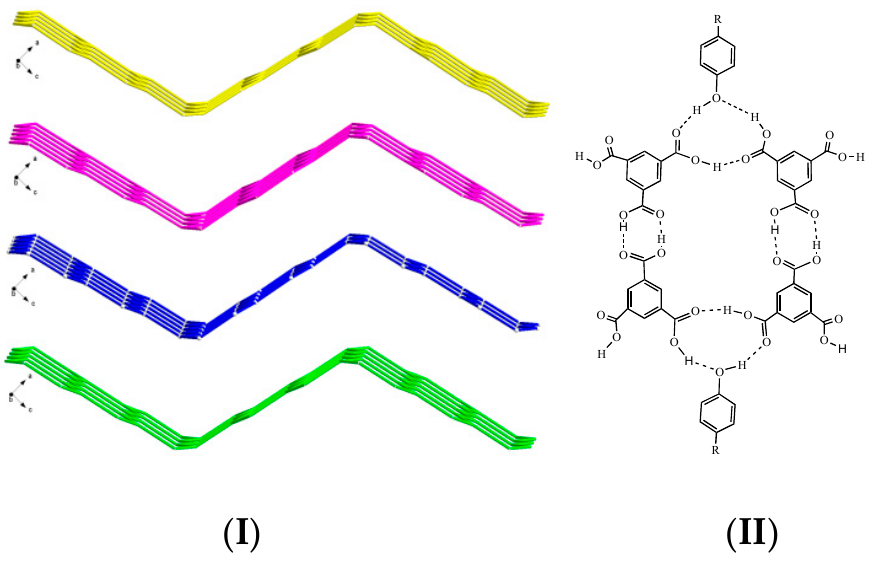
Figure 5. ( I ) Waveform two-dimensional hydrogen-bonded sheets are chosen randomly along the b axis in compound ( 3 ); ( II ) the structure of hydrogen-bonded networks in compounds ( 4 ) and ( 5 ). 3.1.4. Quaternary Compounds [(TMA) · (EP)] ( 4 ) and [(TMA) · (PP)] ( 5 ) Compounds ( 4 ) and ( 5 ) crystallized from a methanol solution in a 1:1 ratio in an asymmetric unit cell (Figures S4 and S5). Single-crystal X-ray diffraction reveals that both compounds ( 4 ) and ( 5 ) crystallize in a monoclinic cell with the C 2/c space group. Unlike compounds ( 1 )–( 3 ), EP/PP replaced two TMA molecules and interconnected to form a tetragonal hole through O − H ··· O hydrogen bonding as shown in Figure 5II. The tetragonal holes further interact with each other to form one-dimensional chains (Figure